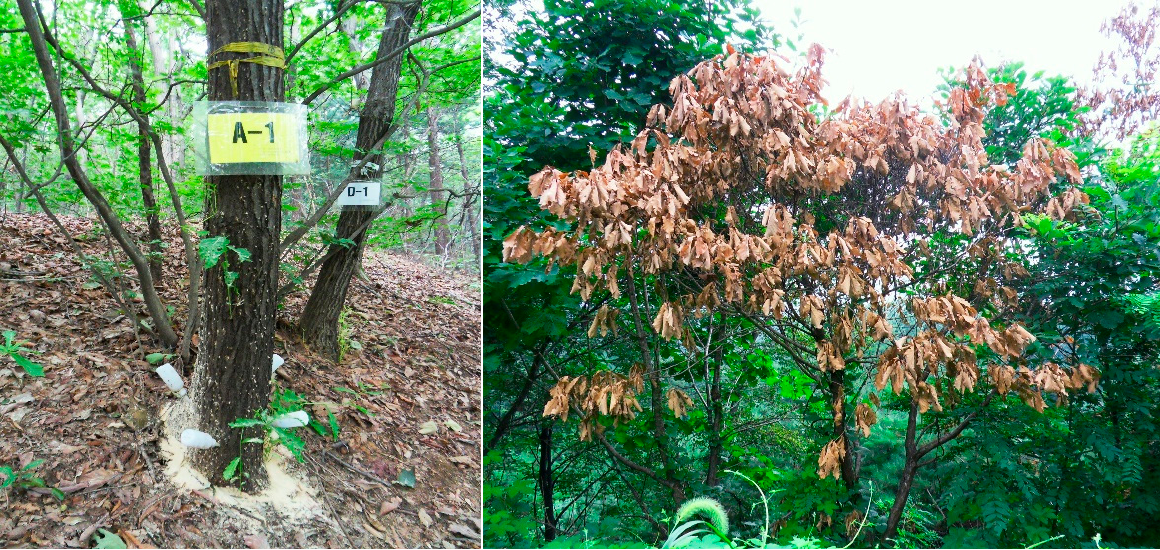
Figure 3. Mongolian oak ( Q. mongolica ) attacked by P. koryoensis ( left ) and wilted by KOW ( right ) (Photos from Park, J.H.).